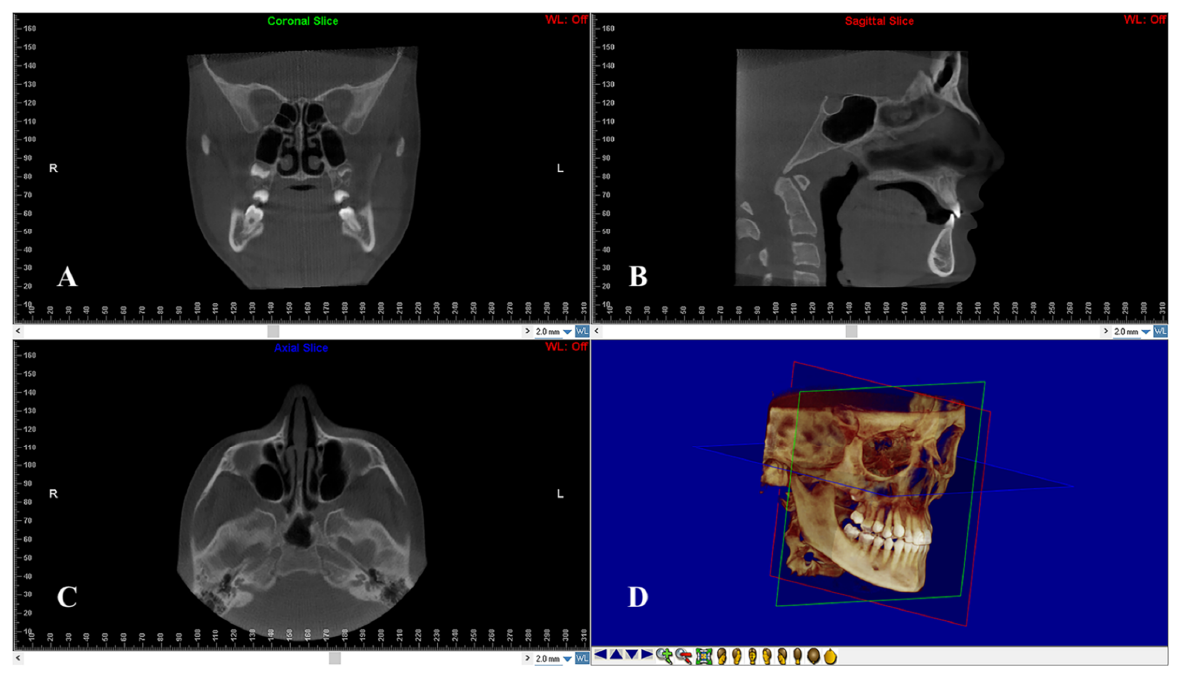
Figure 2. Head re-orientation on coronal ( A ), sagittal ( B ) and axial ( C ) planes of CBCT scans. The 3D image ( D ) shows the head orientation on a 3D space.